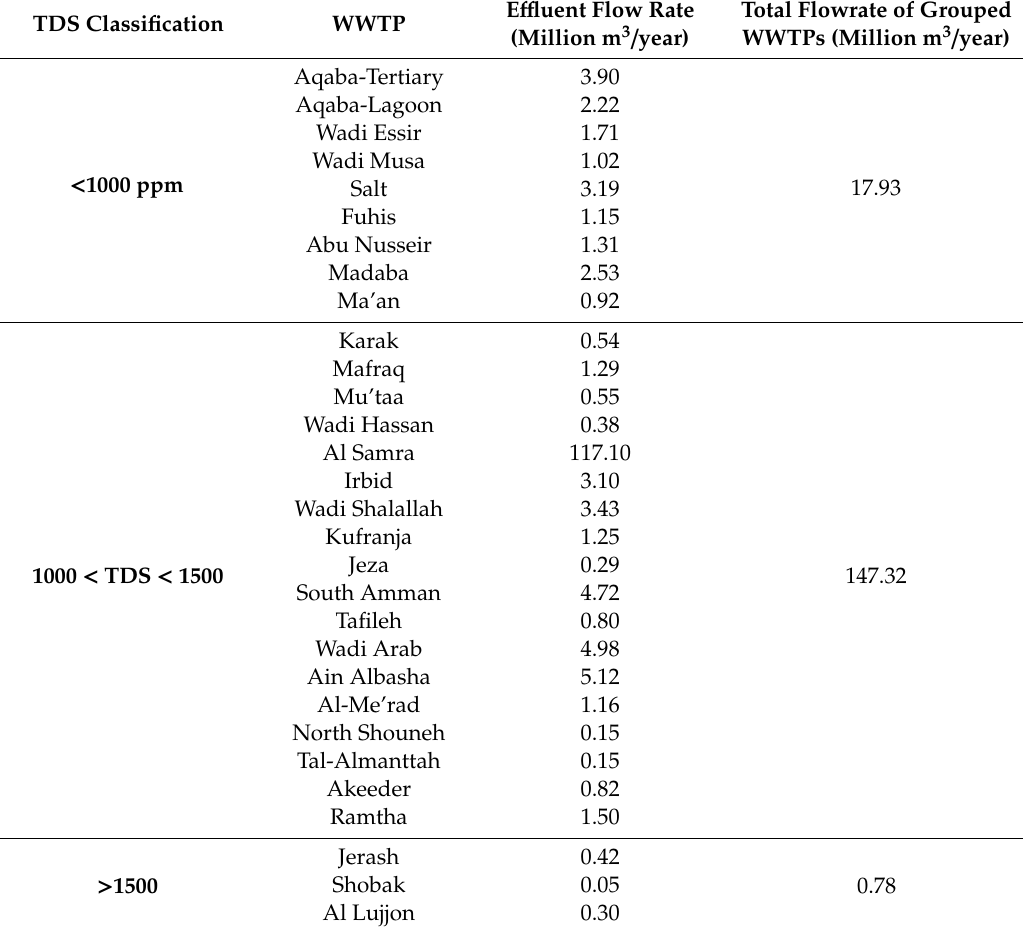
Table 1. Annual WWTP e ffl uent flow rate according to the total dissolved solids (TDSs) classifications. TDS Classification